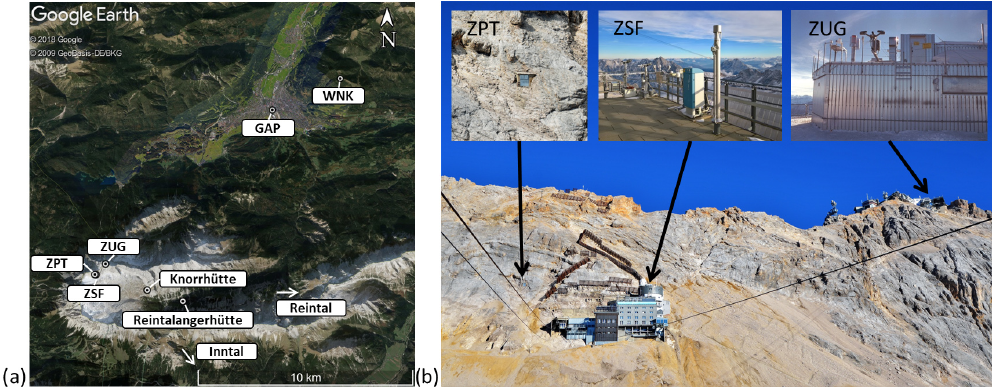
Figure 1. (a) Map showing the study area (GAP – Garmisch-Partenkirchen; WNK – Mount Wank; ZPT – pedestrian tunnel at Mount Zugspitze; ZUG – Zugspitze summit; ZSF – Zugspitze Schneefernerhaus). (b) A photograph showing the locations (ZPT, ZSF, and ZUG) on Mount Zugspitze at which atmospheric CO 2 measurements were